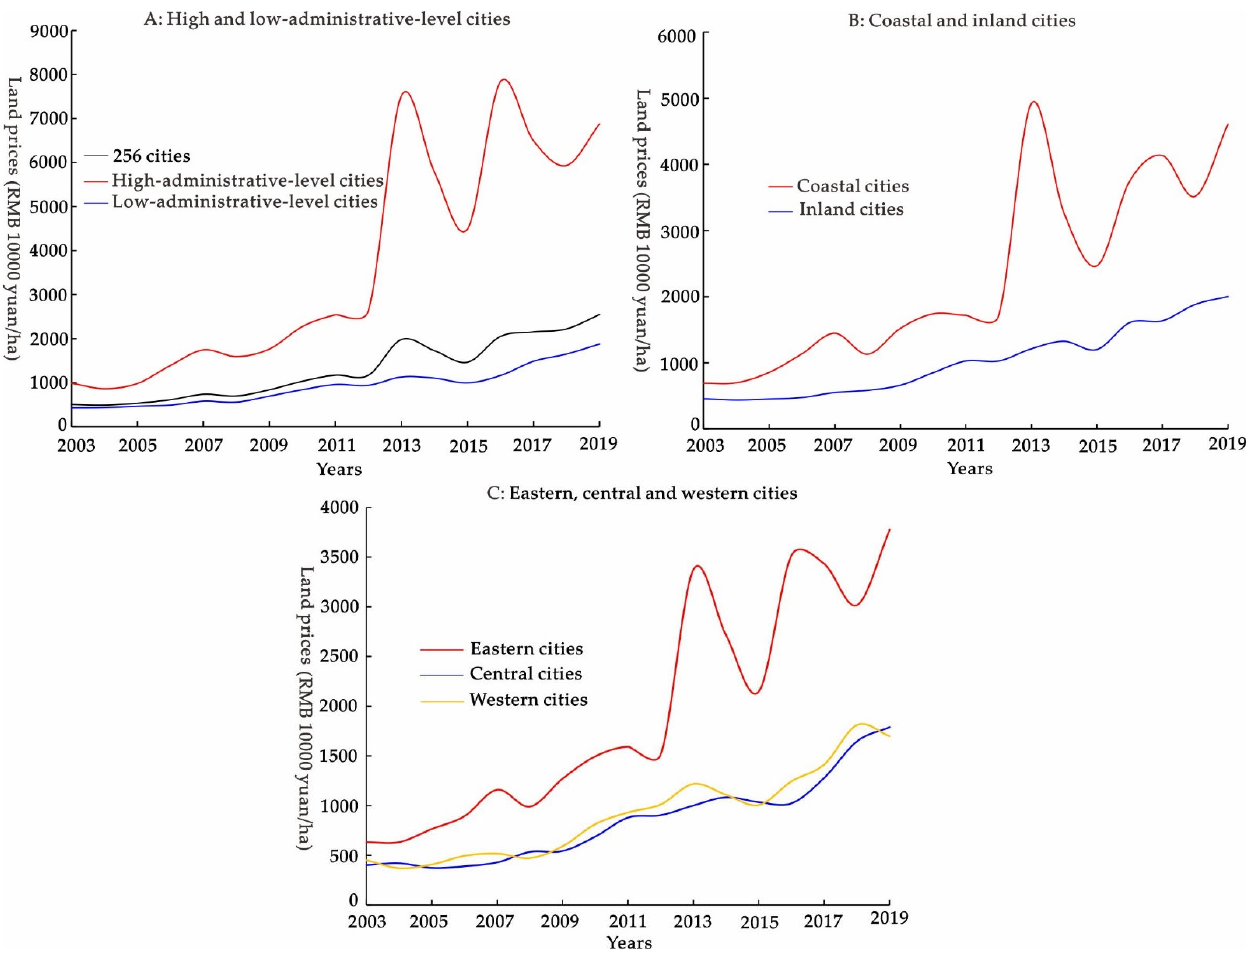
Figure 3. Changes in land prices from 2003 to 2019.